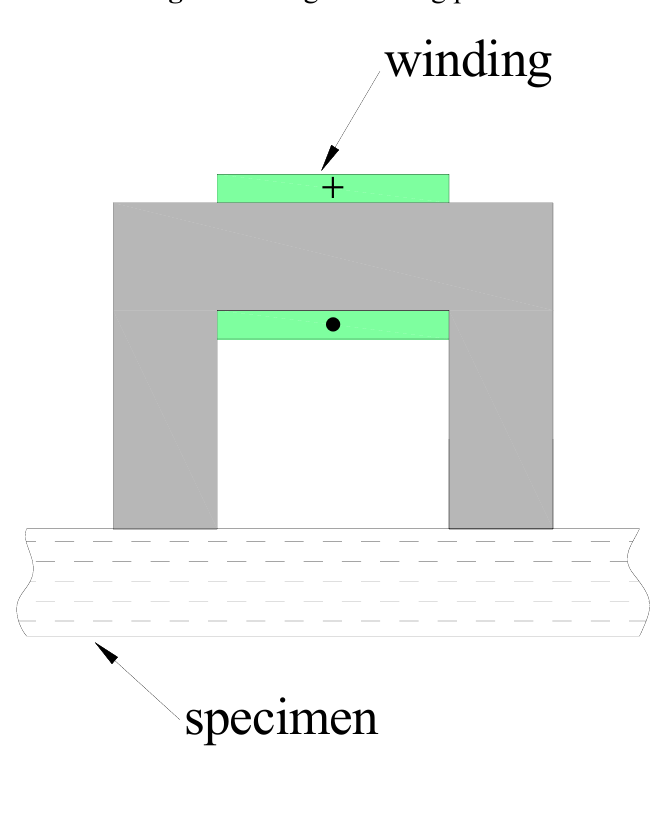
Figure 1. Single winding